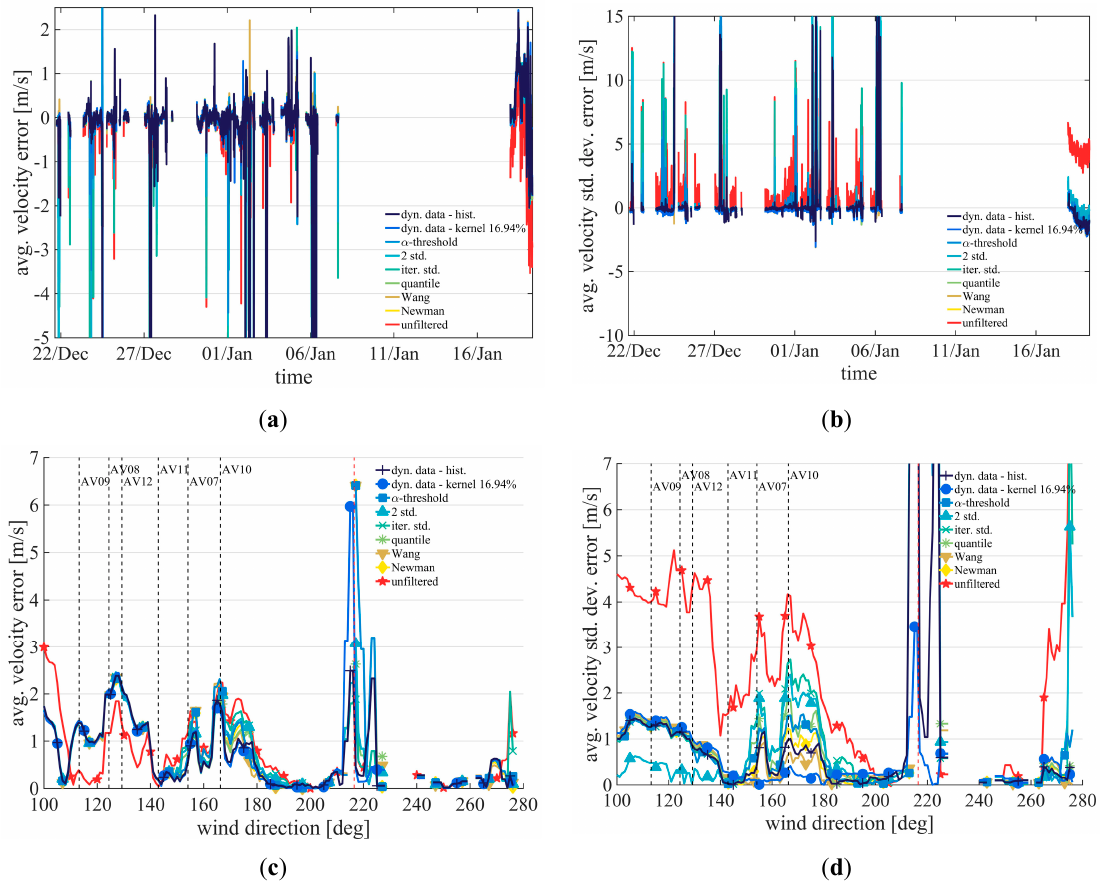
Figure 12. Behaviour of the 10 min averaged filtered staring mode measurements of ( a ) the projected wind speed over time; ( b ) the standard deviation over time; ( c ) average wind speed error over wind direction; ( d ) average standard deviation error over wind direction. Vertical dashed lines indicate the wind direction of possible wake shading of the anemometer on FINO1 based on geometrical correlations.